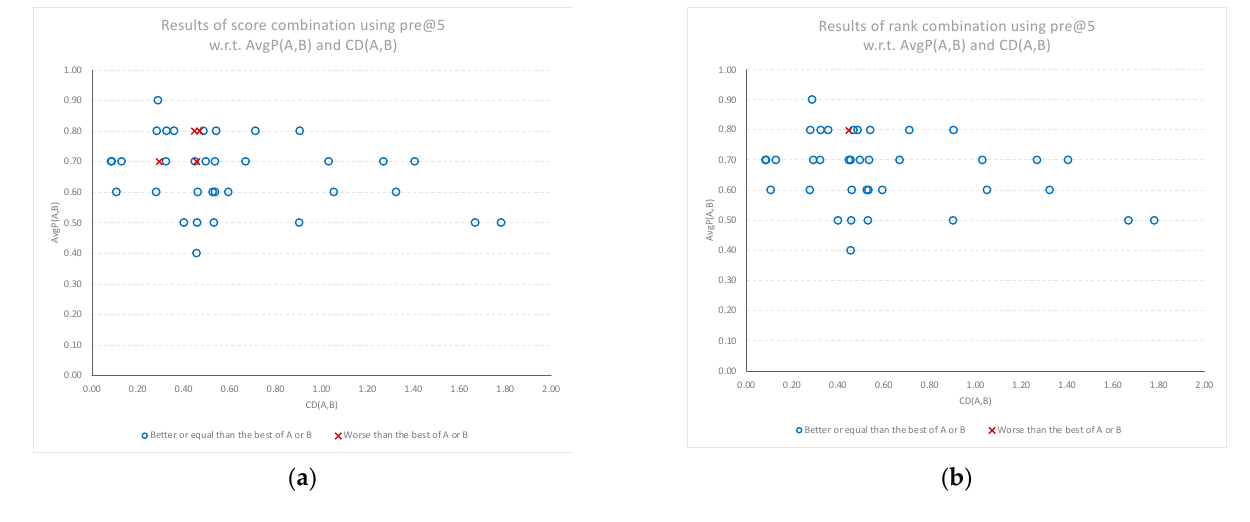
Figure 8. Relative performance of the combined models compared to the best of the individual models (best of A or B) for the top five classifications, plotted against the average performance (AvgP) of the individual models and cognitive diversity. ( a ) Results when using score combination SC ( A , B ). ( b ) Results when using rank combination RC ( A , B ).